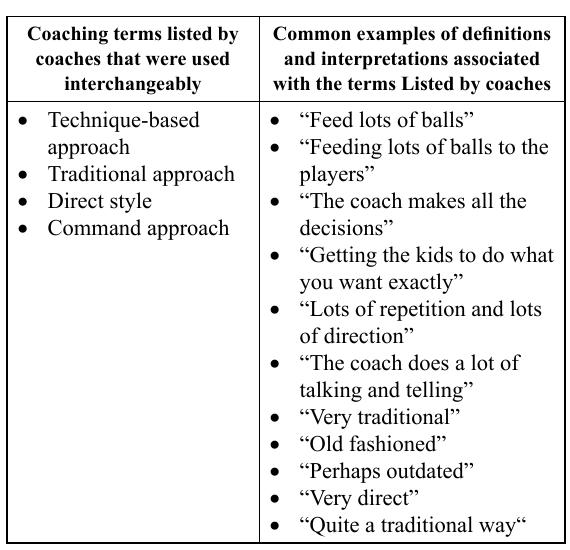
Table 3. Outline of the additional terms that the interviewed coaches used interchangeably and common examples of